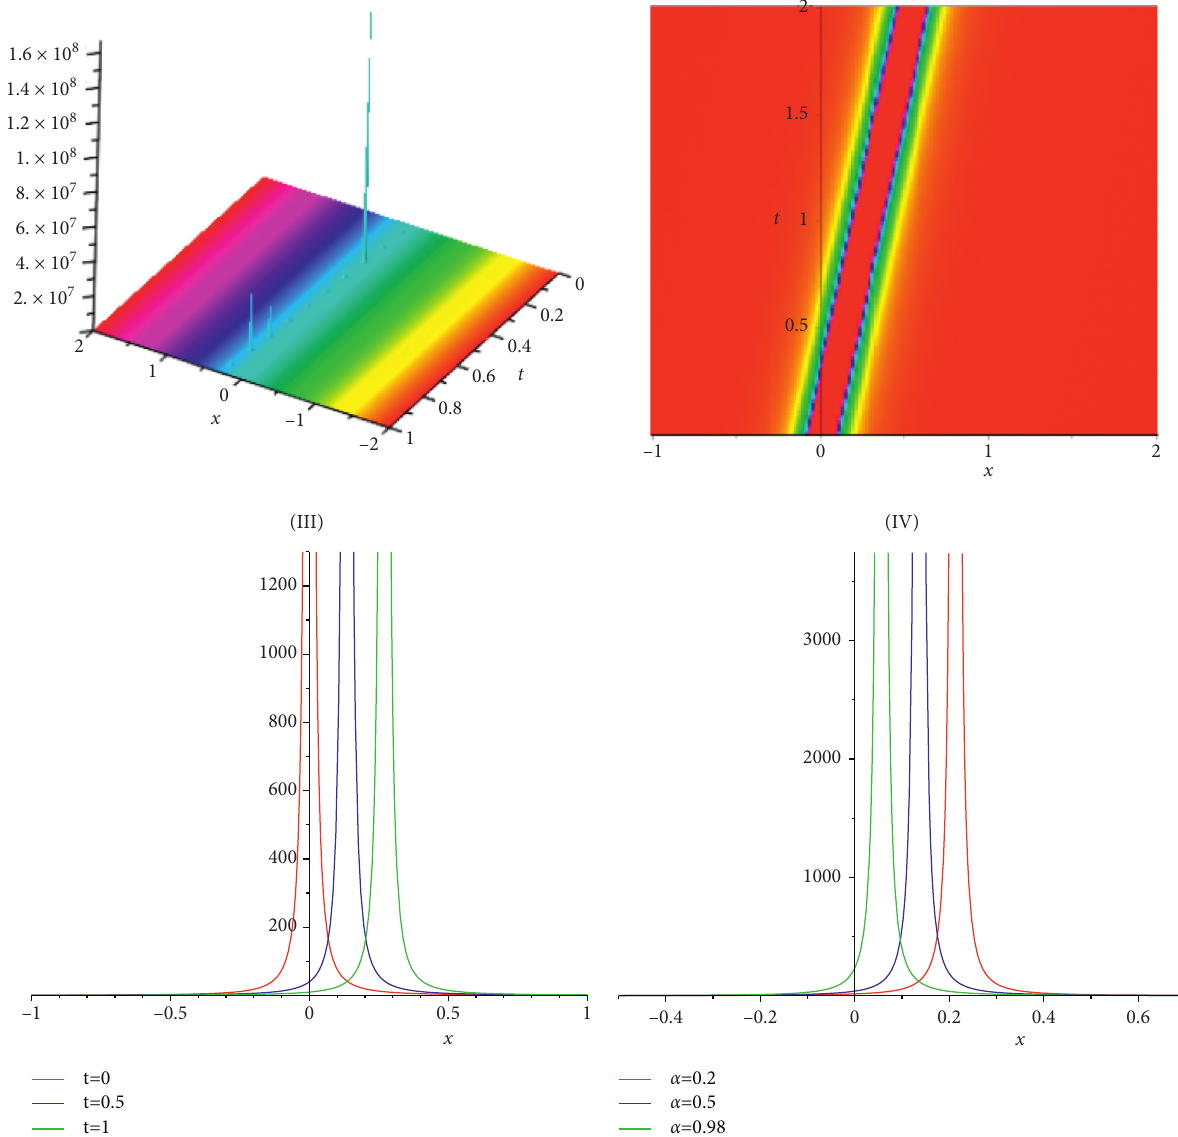
� 0 . 3 ,k � 0 . 4 ,k � 0 . 5 , α � 1 2 3